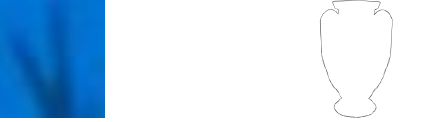
Figure 8. Shapes to be searched. “Fish tale” (left) and Amphora (right)